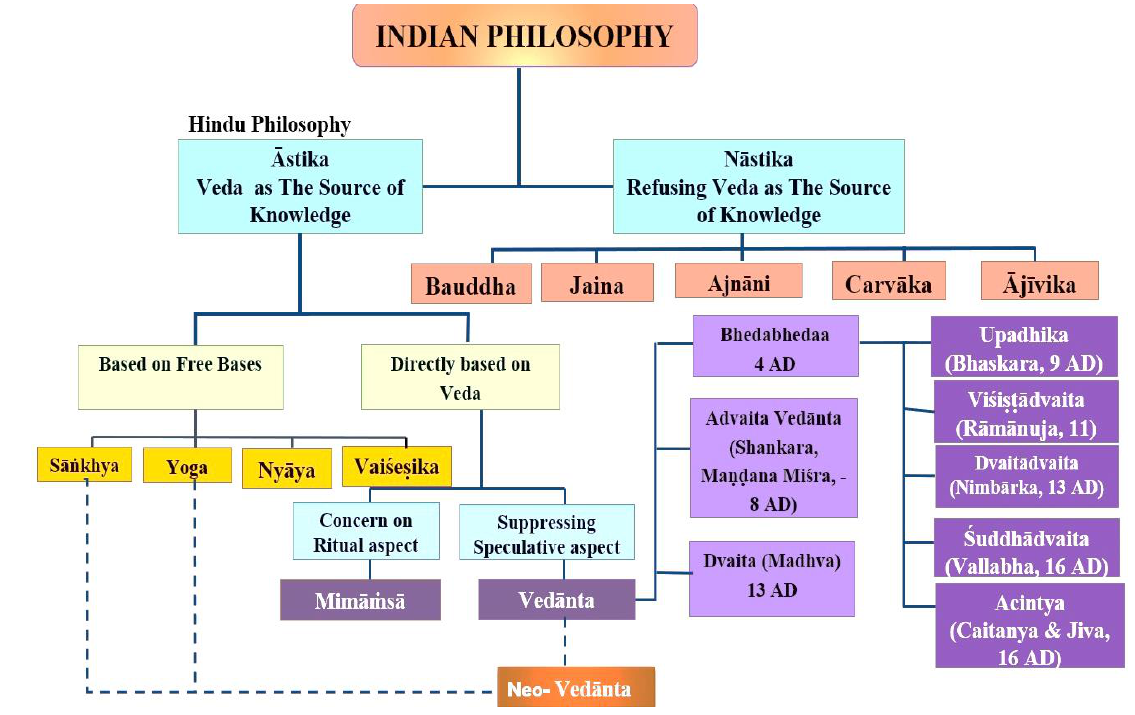
Fig. 1 Indian Philosophy Chart (Surpi et al.